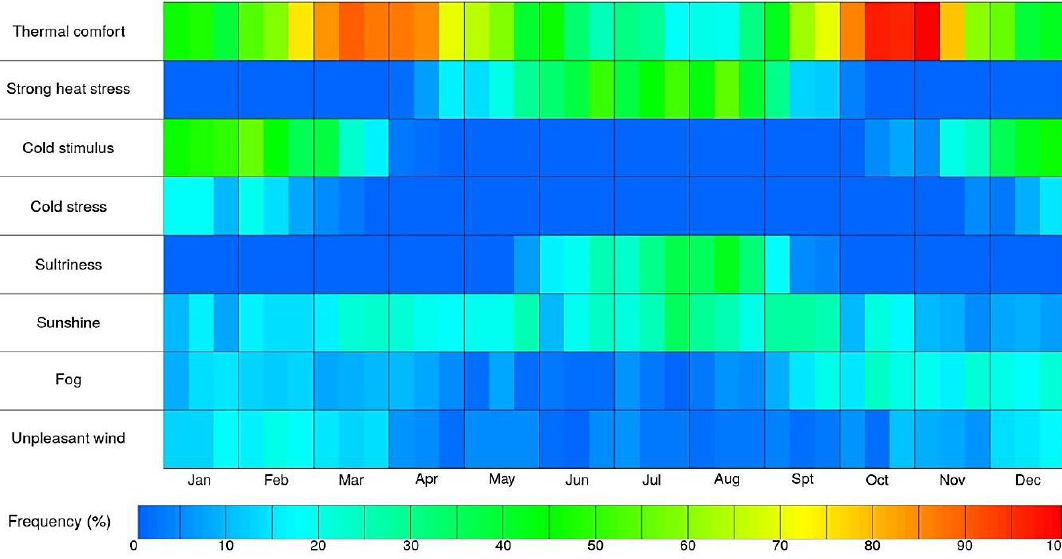
Figure 7. CTIS of the city of Freiburg, extracted from the AOI of southern Baden, averaged over the time period 1995–2012 (6–18 UTC).